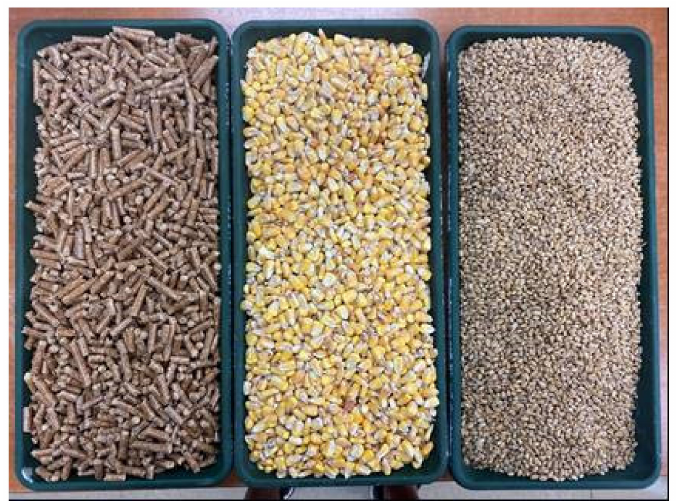
Figure 1. Samples of wood pellets ( left ), maize ( centre ) and wheat ( right ). The wood pellets used in this work corresponded to natural wood (100%). Their main characteristics were as follows: diameter = 6 ± 1 mm; length = 3,15 < L ≤ 40 mm; fines ≤ 0.5%; net calorific value ≥ 4.6 kWh/kg; ash ≤ 0.7%; moisture ≤ 10%; bulk density = 600 ≤ DB ≤ 750 kg/m 3 ; mechanical durability ≥